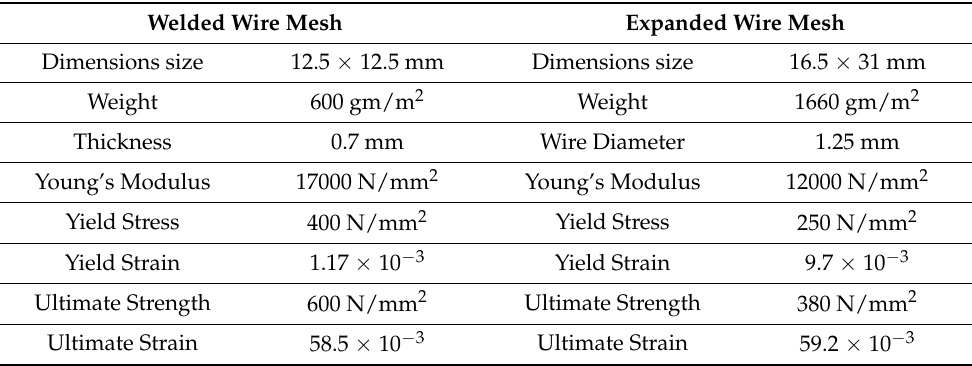
Figure 5. Fiber glass mesh. Table 3. Mechanical properties of the welded and expanded wire-meshes [29].